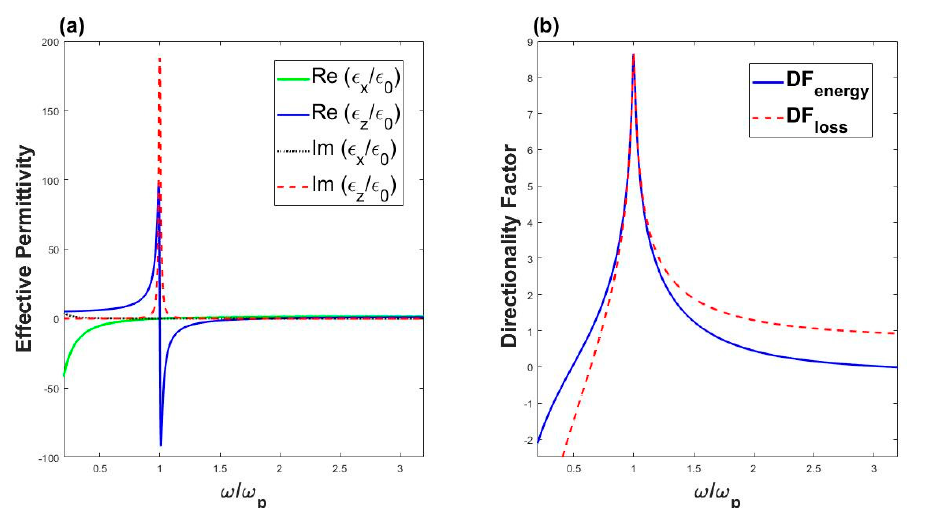
Figure 2. Numerical results for Equations (18) and (27). The relative permittivity of the dielectric layers is assumed to be (cid:101) ε d = 2.5, and the filling fraction is chosen as f = 0.5. In ( a ), we plot the two principal values of the effective permittivity tensor as functions of frequency. They correspond to the direction parallel and normal to the layers (See Equation (18)). The green and blue curves are the real parts, whereas the black dotted curve and the broken red curve are their imaginary parts. In ( b ), we show the directionality factors for the energy density (the blue curve) and power loss (the red broken-line curve). These two factors are defined as the natural log of the ratio between the coefficients of | (cid:101) E z | and | (cid:101) E x | in Equations (27) and